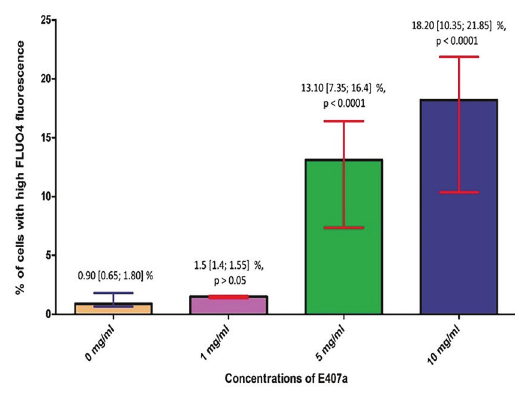
Figure 4 - The amount of cells with enhanced FLUO4 fluorescence after exposure to semi-refined carrageenan